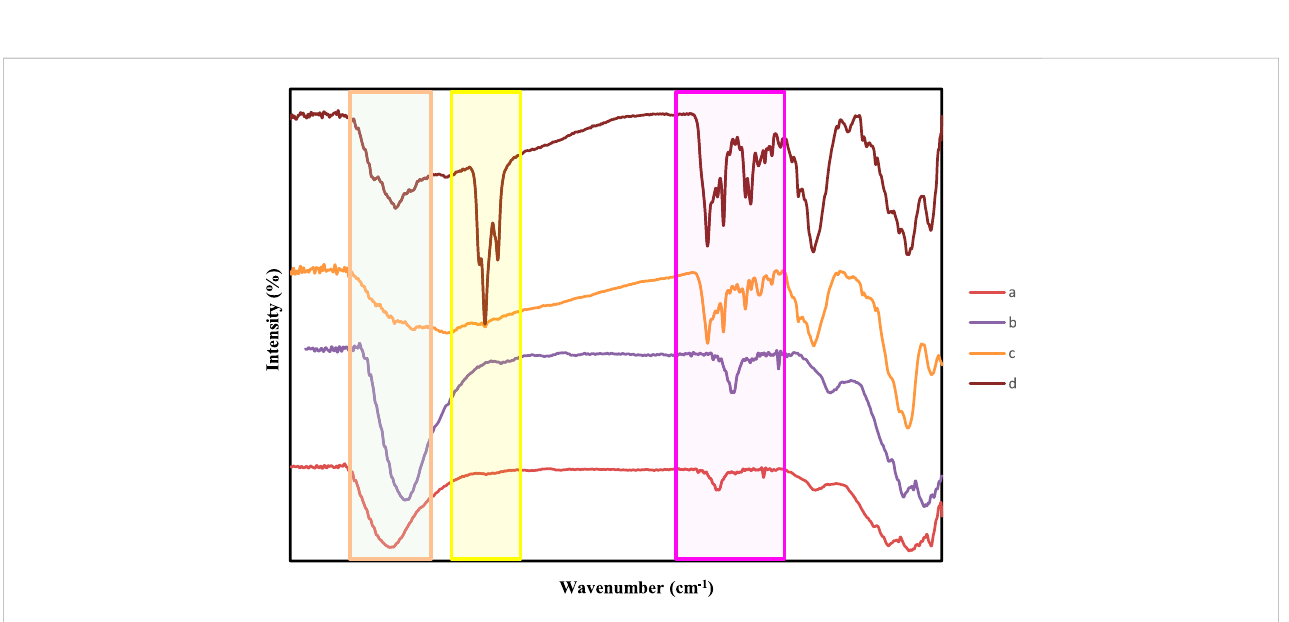
FIGURE 5 FT-IR spectra of (A) Fe 3 O 4 @SiO 2 , (B) Ti 3 C 2 @FA (C) Ti 3 C 2 -Fe 3 O 4 @SiO 2 -FA, and (D) Ti 3 C 2 -Fe 3 O 4 @SiO 2